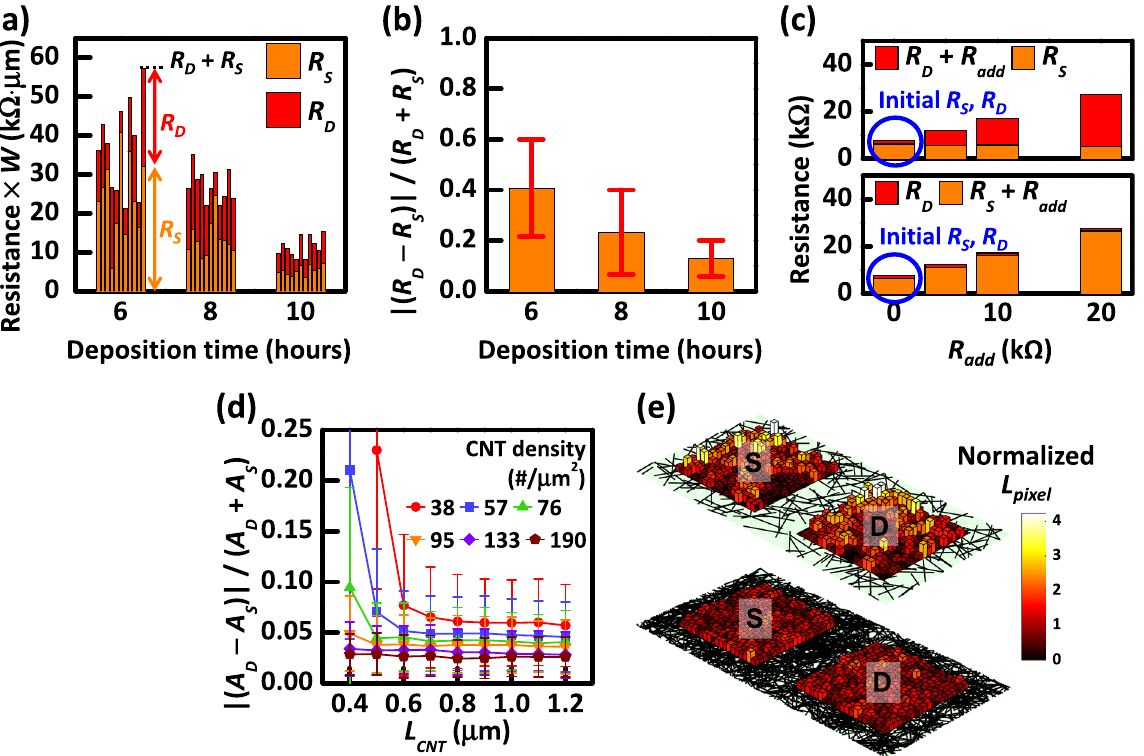
Figure 4. ( a ) Individual R S and R D values extracted from 11 CNT-TFTs for different densities of CNTs in the network. ( b ) Measured |( R D − R S )|/( R D + R S ) of CNT-TFTs for different densities of CNTs. ( c ) R S and R D values of CNT-TFTs extracted with external resistance ( R add ) intentionally loaded source and drain electrodes. ( d ) Simulated asymmetric ratio of |( A D − A S )|/( A D + A S ) of CNT-TFTs for different densities and lengths of CNTs. ( e ) Simulated distribution of contact resistance for high and low densities of CNTs in the